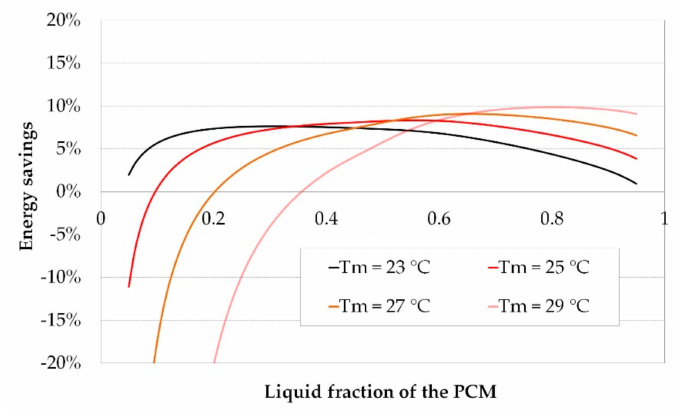
Figure 12. Energy savings obtained with the PCM mode for di ff erent values of daily mean temperature ( T m